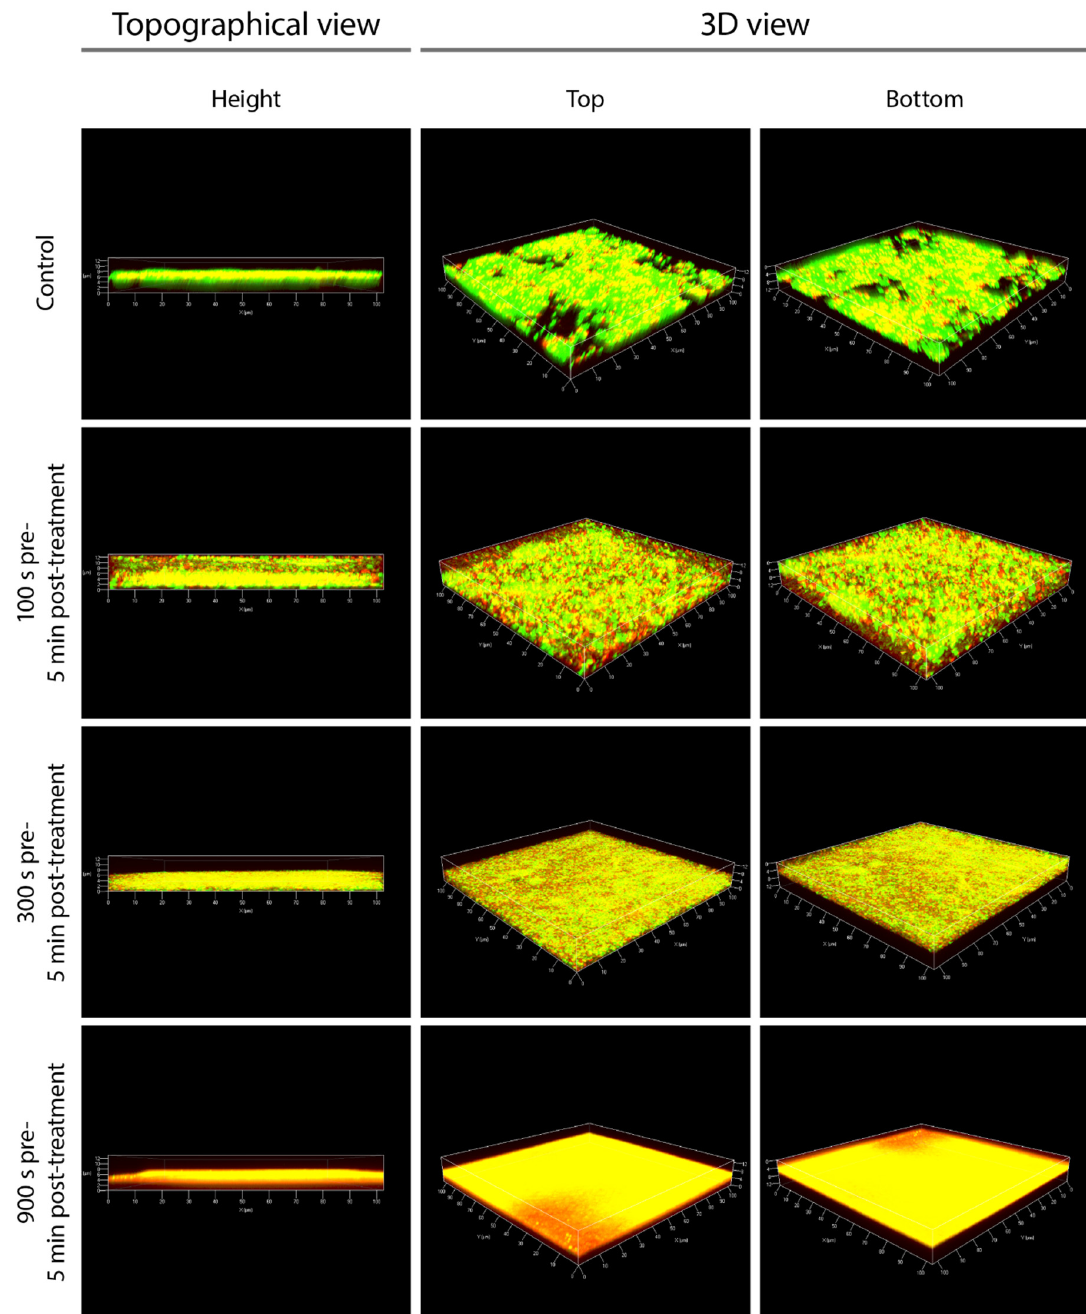
Figure 5. The images show P. fluorescens biofilms with and without treatment with plasma-treated water (PTW). Left panels show a topographical view of the biofilm layer (height view of the biofilms in µm). Central and right panels show 3D images with a top and a bottom view of the biofilms, respectively. The pretreatment time is the treatment time of the water by the plasma source (MidiPLexc) and the post-treatment time is the contact time of the PTW with the biofilm. For each biofilm, an area of 100 × 100 µm is visualized.